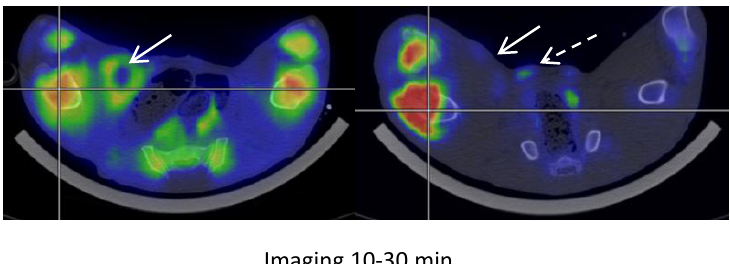
Figure 7. [ 68 Ga]Ga-DOTA-Siglec-9 uptake in the lungs.